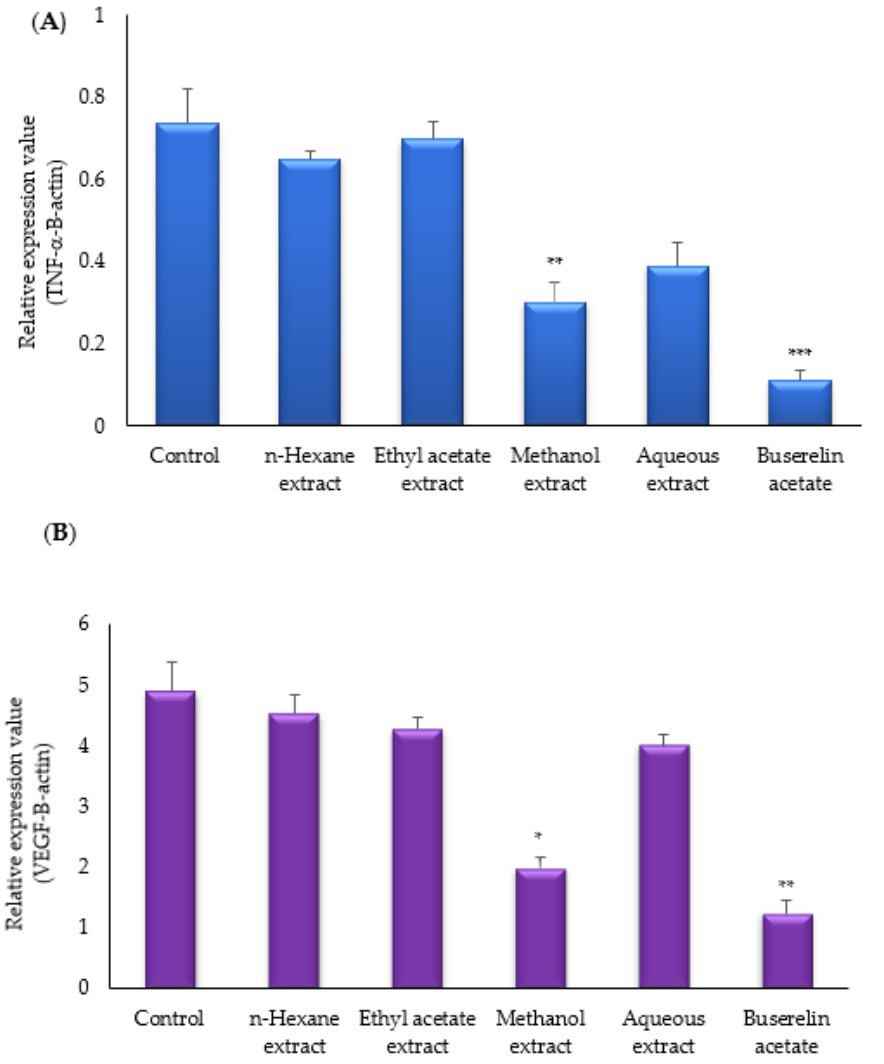
Figure 4. Effects of M. neglecta on mRNA ( A ) expression of TNF-alpha, ( B ) VEGF-A in endometrial tissue of rats. Values are means and Ds. Values were compared by ANOVA, * p < 0.05; ** p < 0.01; *** p < 0.001 vs. control.